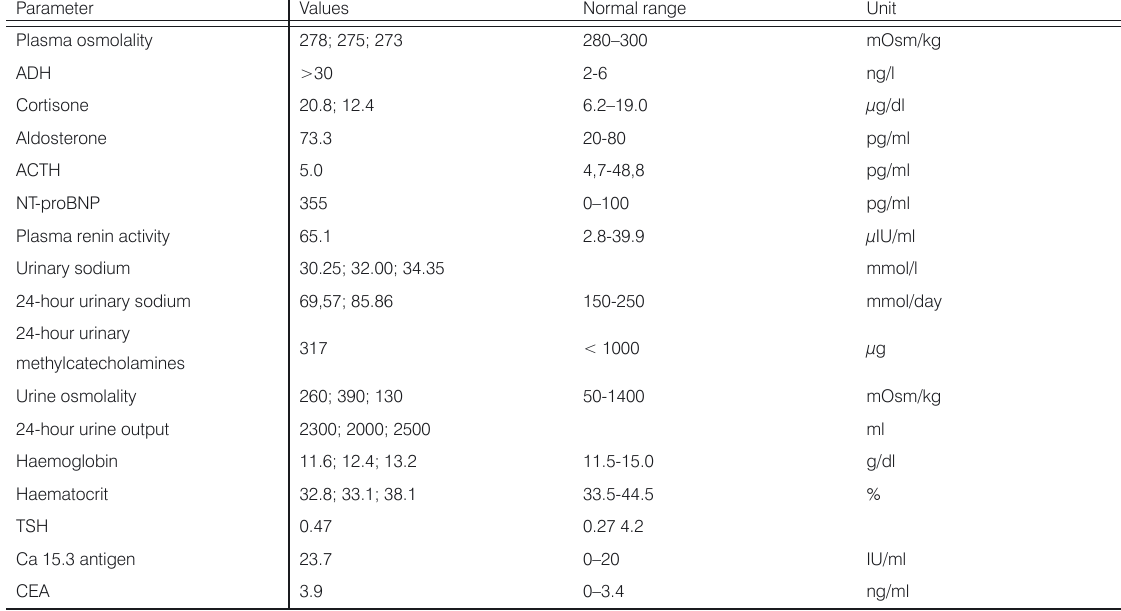
Table 1. Clinically relevant laboratory